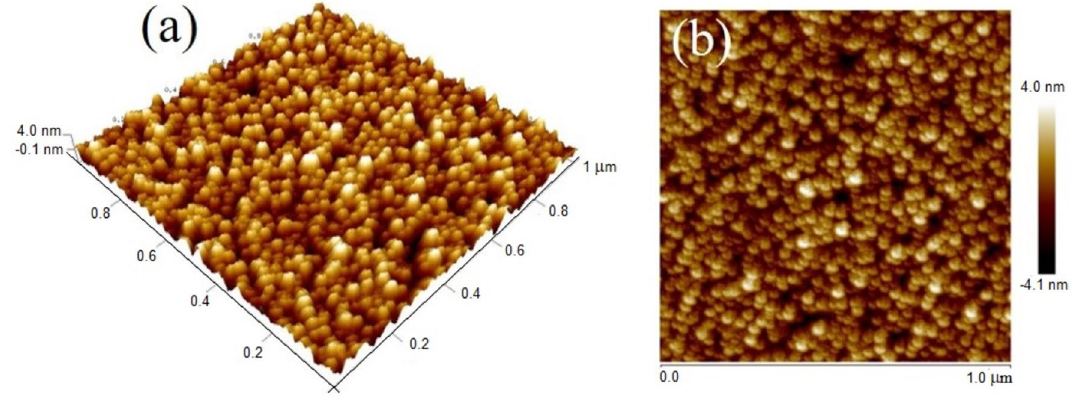
Figure 4. AFM images of the heterostructures BZT/BCT: ( a ) 3D and ( b )